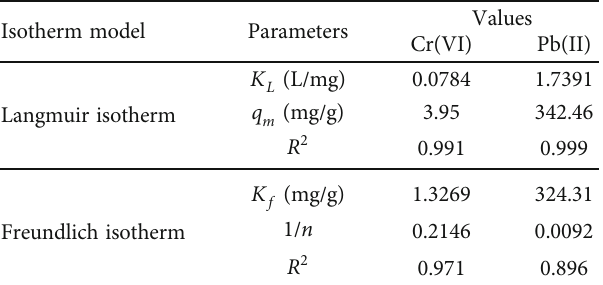
Figure 6: Langmuir isotherm plot for the removal of Cr(VI) and Pb(II) by RHA-based zeolite FAU. Table 2: Parametric values of Langmuir and Freundlich isotherm data.